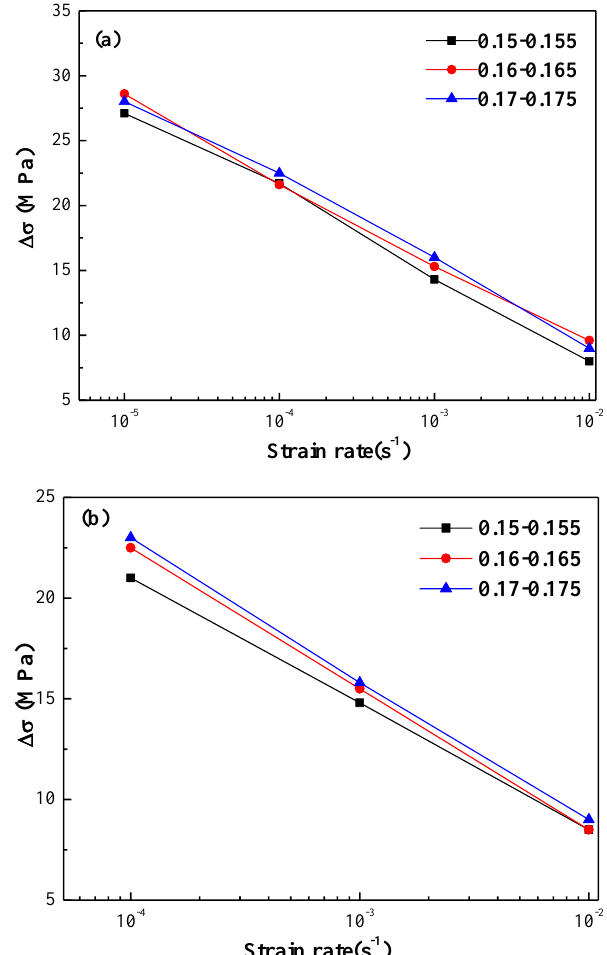
Figure 9. The r elationship between the average serration magnitude and the strain rate in ( a ) annealed and ( b ) quenched 5083 Al alloy sheets. and ( b ) quenched 5083 Al alloy